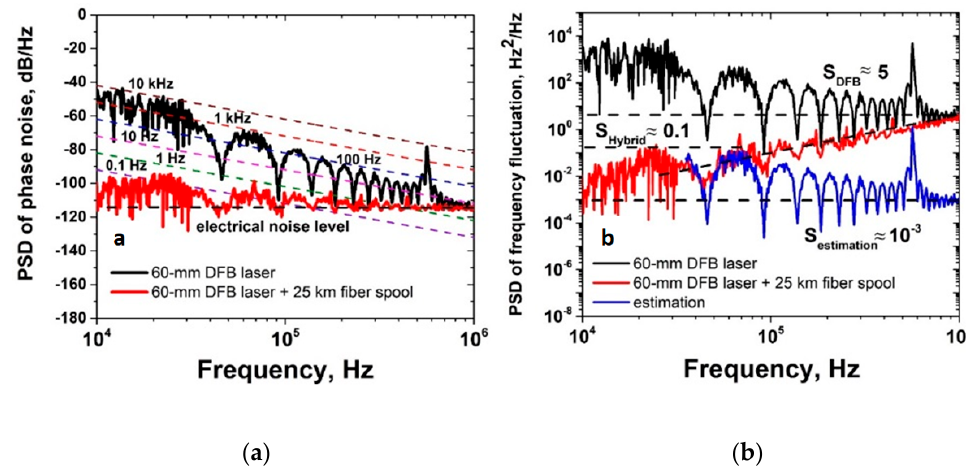
Figure 4. ( a ) Phase noise PSD obtained for a DFB laser in conventional (black) and hybrid (red) configurations. ( b ) Frequency fluctuation PSD obtained for a DFB laser in conventional (black) and hybrid (red) configurations and estimation above 100 kHz (blue).